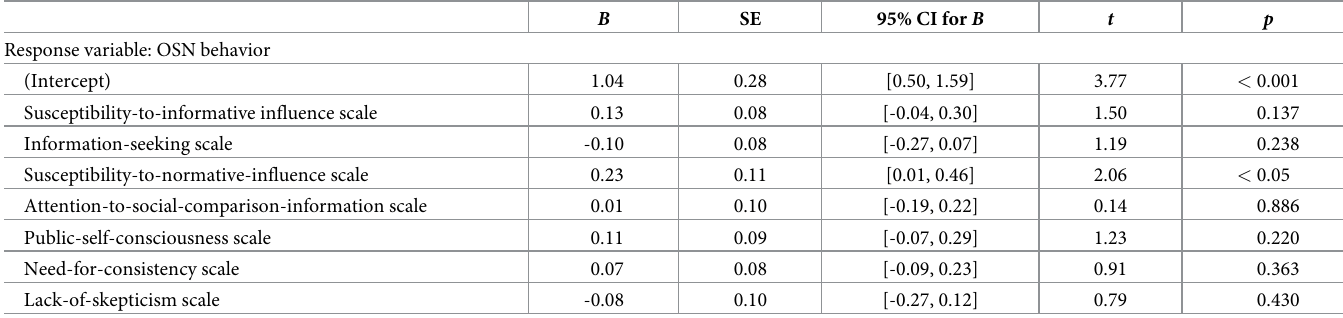
Table 1. Testing whether SSI scales predict OSN behavior.